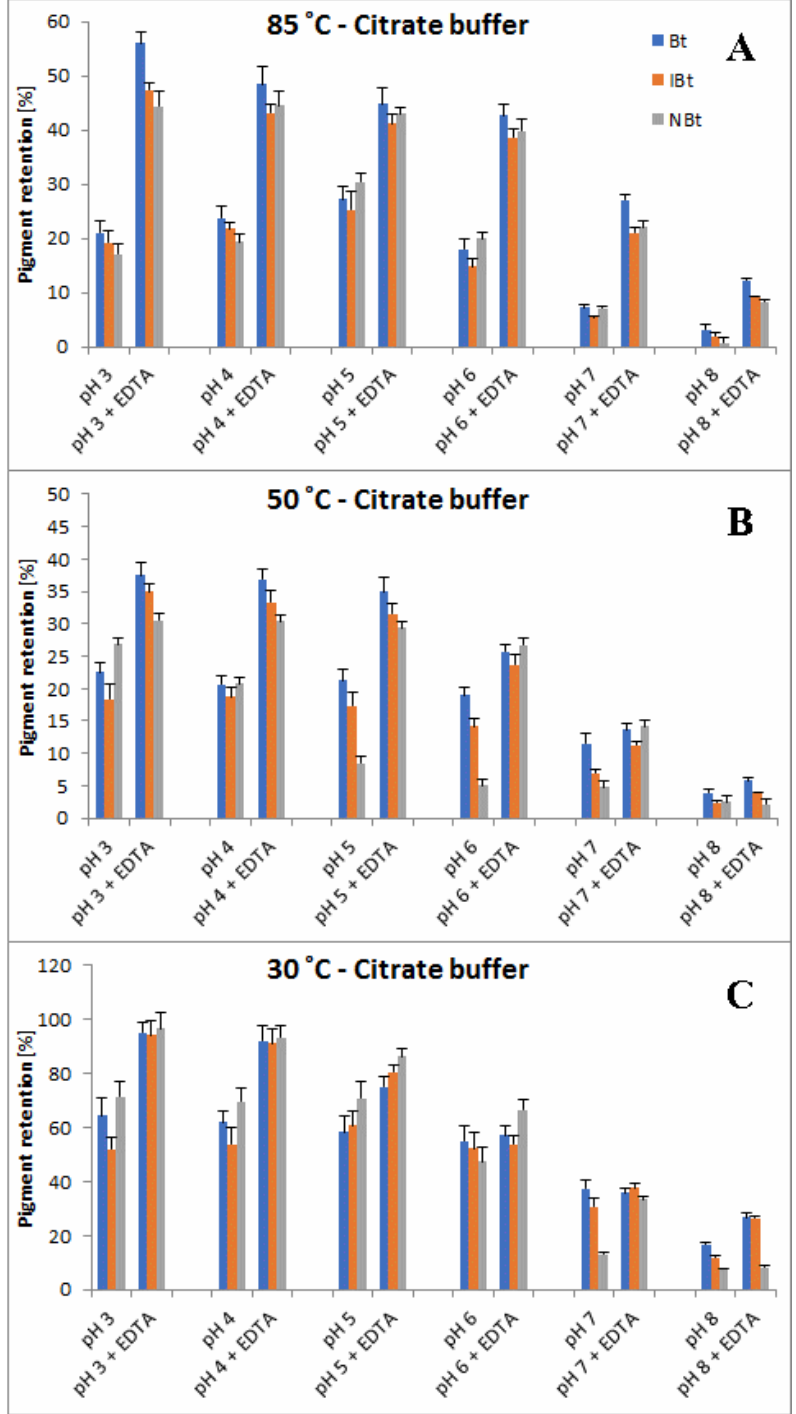
Figure 10. Pigment retention values [%] of betanin 1 , isobetanin 1’ and neobetanin 10 with optional addition of EDTA after long-term heating of the BRE extract for 1 ( A ), 7 ( B ) and 72 h ( C ) in citrate buffers at 85, 50 and 30 °C, respectively.